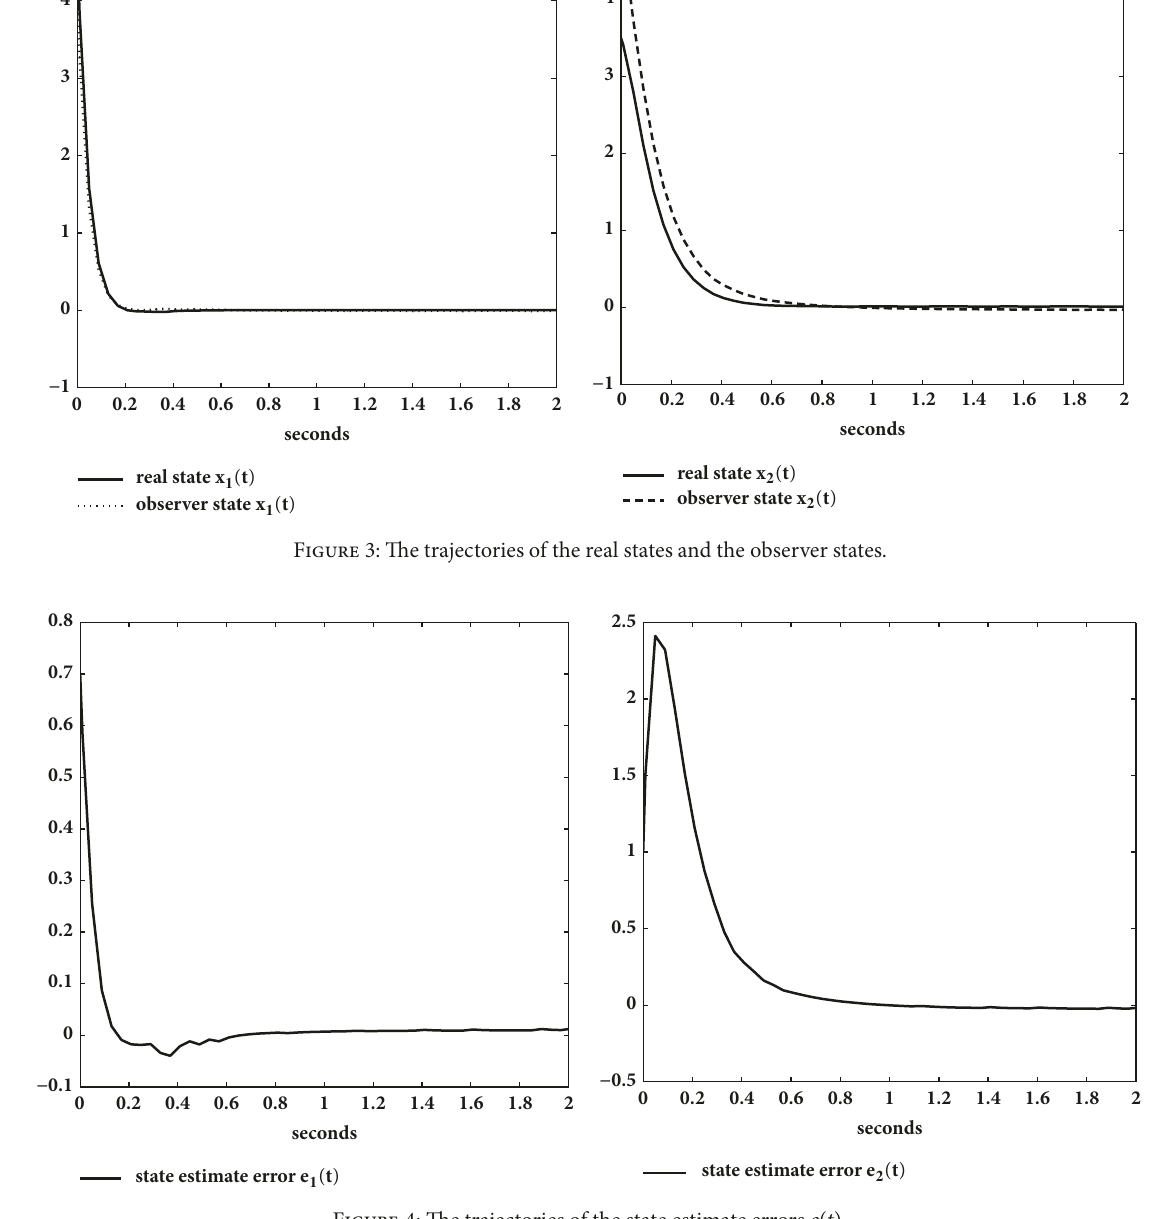
Figure 4: The trajectories of the state estimate errors 𝑒(𝑡)